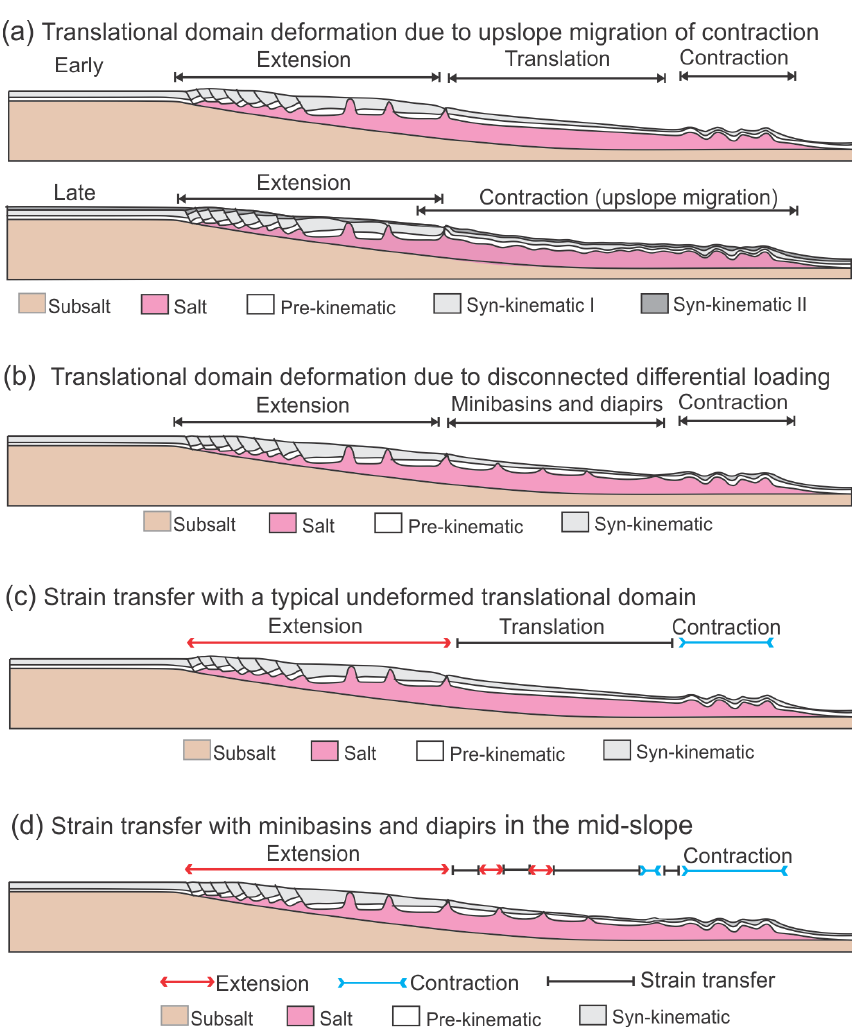
Figure 10. Proposed mechanisms of overprinting translational domains and models illustrating strain transfer with underformed translational domain, and areas of minibasins and diapirs. (a) Low sedimentation rate and thin supra-salt cover allows upslope migration of contraction resulting in overprinting the translational domain. (b) Sedimentary differential loading leads to the development of minibasins and diapirs in the mid-slope preventing the establishment of a stable, undeformed translational domain. (c) The undeformed translational domain in the mid-slope allows strain transfer (ST) without significant internal deformation. (d) The minibasins and diapirs in the mid-slope allow strain transfer (ST) through a combination of passive movement of minibasin and minor widening (extension) or shortening (contraction) of